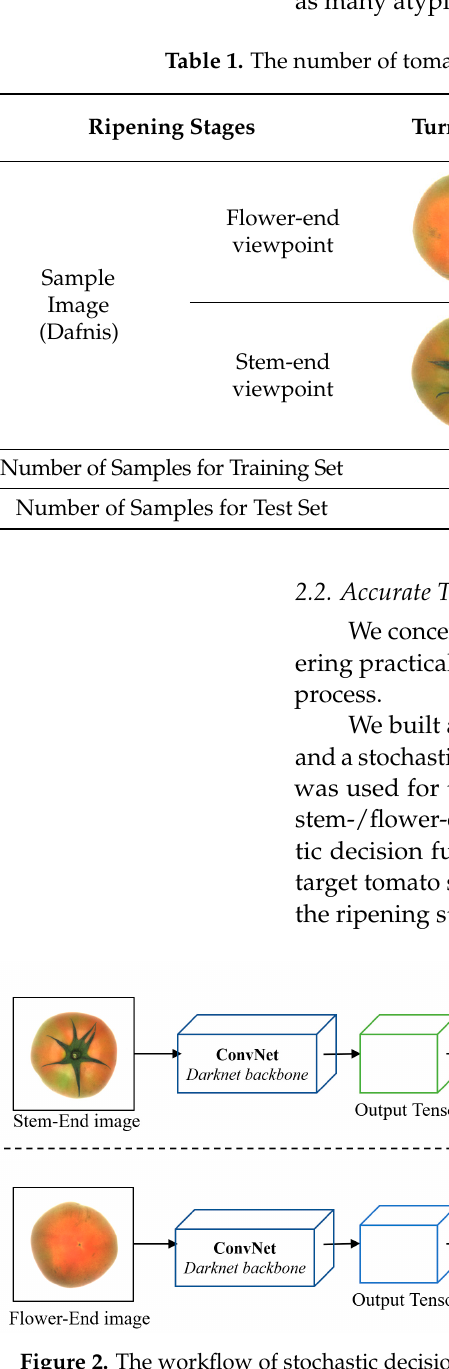
Figure 2. The workflow of stochastic decision fusion of convolutional neural networks (SDF-ConvNets) for tomato ripeness detection (NMS: non-maximum suppression).